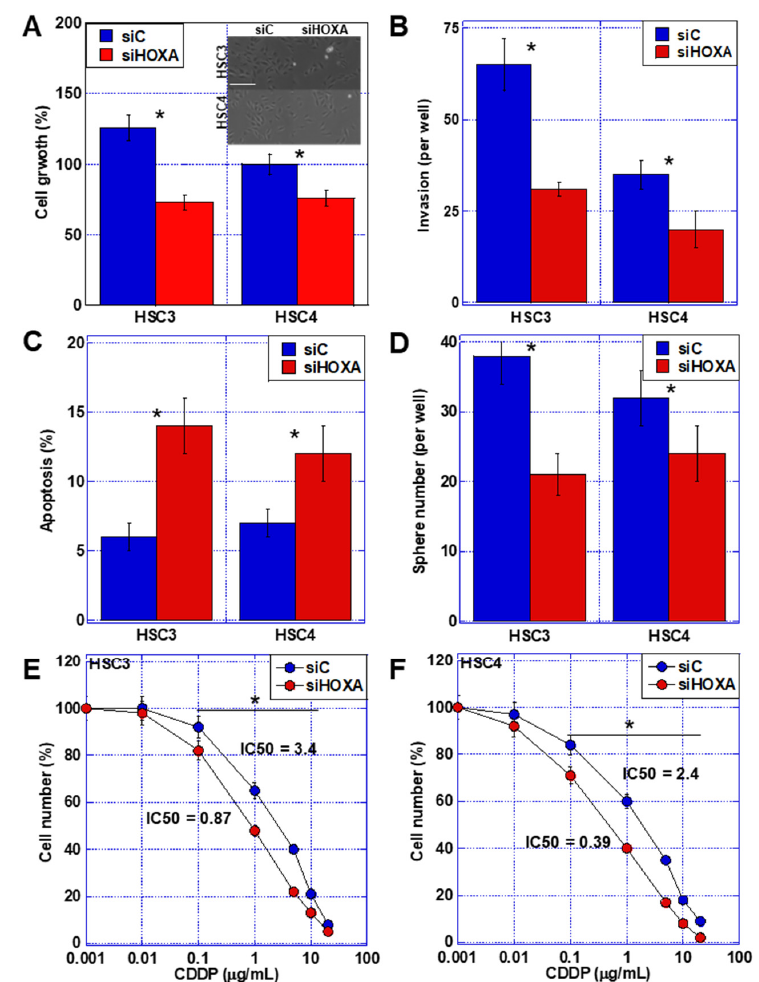
Figure 3. Effect of HOXA11-AS knockdown on malignant phenotypes in OSCC cells. ( A – D ) Effect of HOXA11-AS knockdown on cell growth ( A ), invasion ( B ), apoptosis ( C ), and sphere formation ( D ). (Inset in ( A )) Cell morphology. Scale bar, 50 μ m. ( E , F ) Effect of HOXA11-AS knockdown on sensitivity to CDDP in HSC3 ( E ) and HSC4 ( D ) cells. Error bars indicate the SD calculated using Student’s t -test from three independent trials. Asterisk, p < 0.05. OSCC, oral squamous cell carcinoma; siHOXA, small interfering RNA for HOXA11-AS ; siC, control small interfering RNA; CDDP, cisplatin.